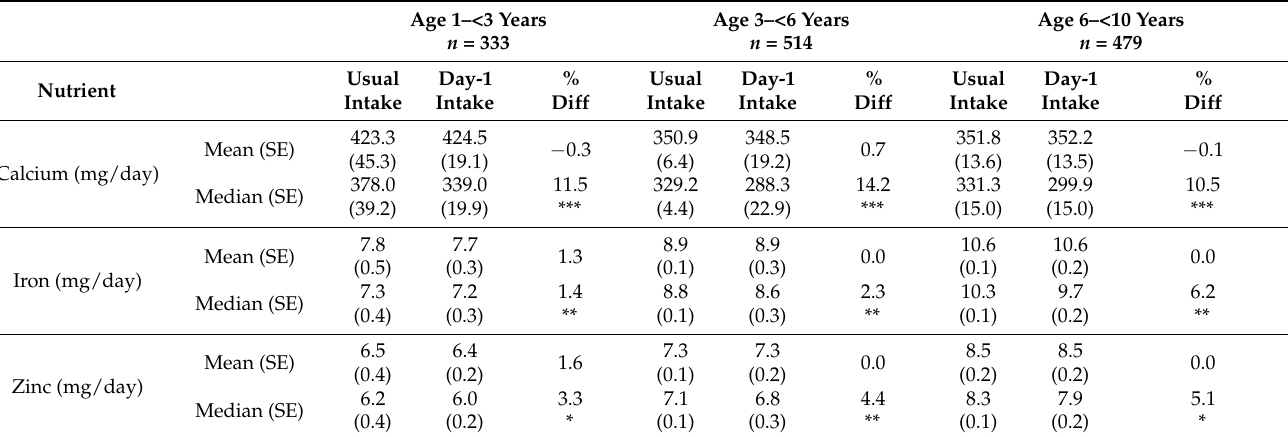
Table 1. Mean (SE of the mean), median (SE of the median) and percentage difference (usual intake versus Day-1 intake) for calcium, iron and zinc intake, by age group.